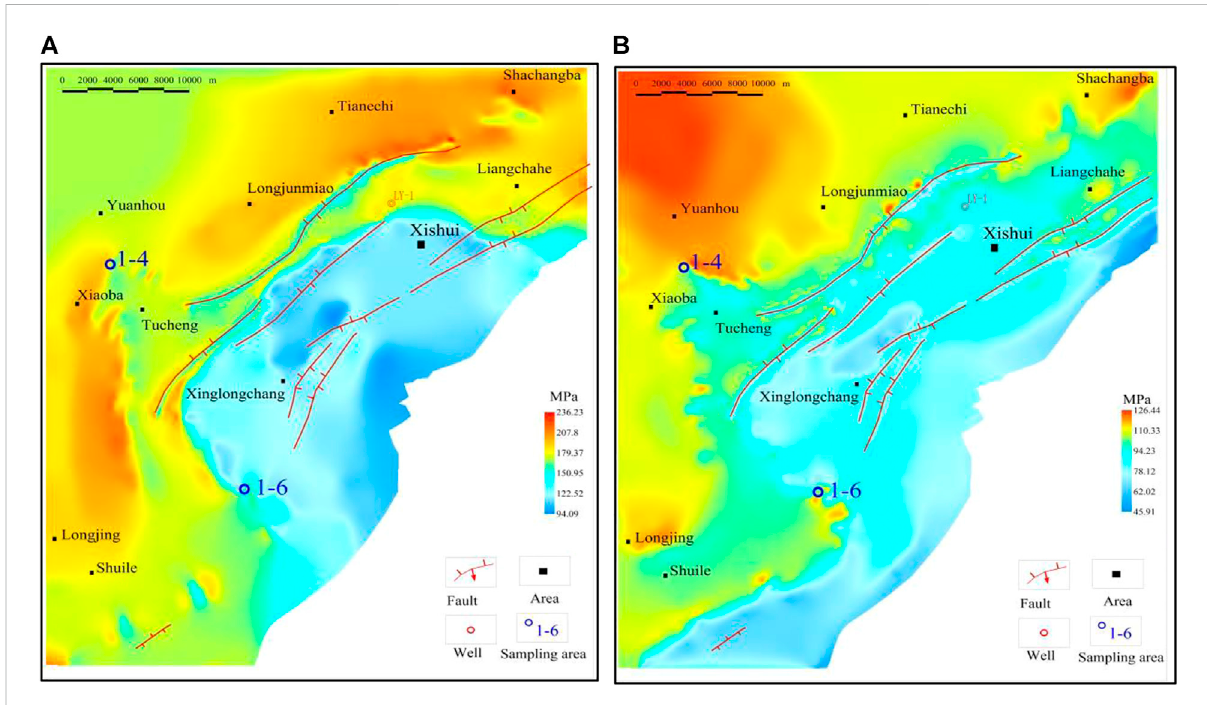
FIGURE 9 Numerical simulation results of paleo-tectonic stress fi eld in Lintanchang area during the Middle Yanshanian period ( (A) : maximum principal stress; (B) minimum principal stress).